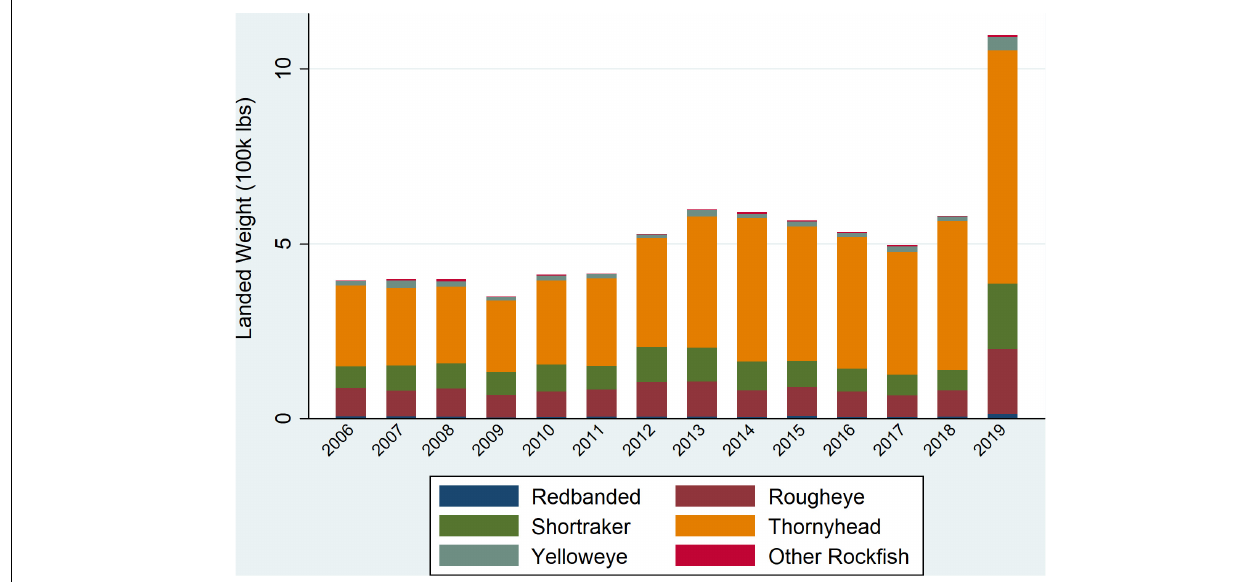
FIGURE 10 | Rockfish bycatch for the sablefish IFQ fleet, for the top six rockfish species landed by volume.